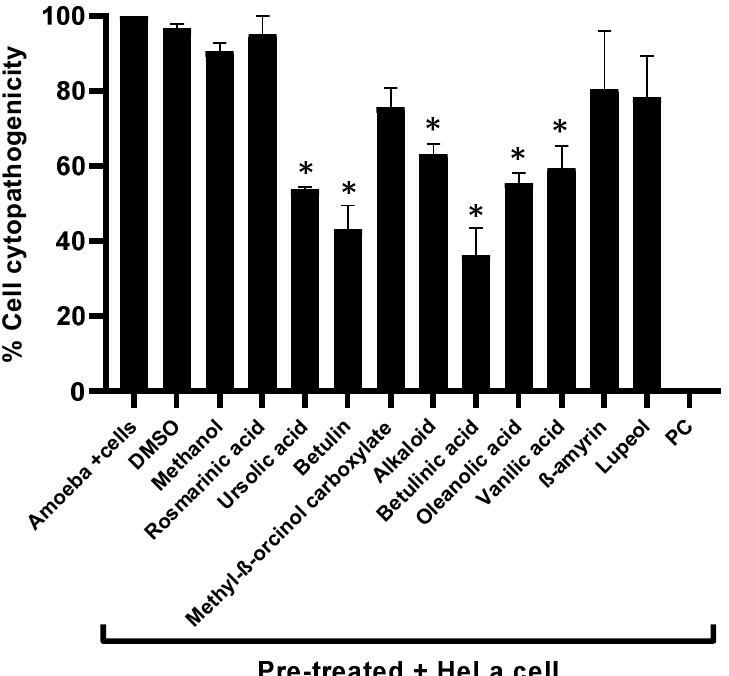
Figure 6. The cytopathogenicity of human cells was declined by pretreating A. castellanii with compounds. The results revealed considerable inhibition of amoeba-mediated host cytotoxicity when compared with amoeba (untreated). Data are presented as mean ± standard error. p values were calculated using a two-sample t -test with two-tailed distribution, and (*) denotes that p < 0.05.